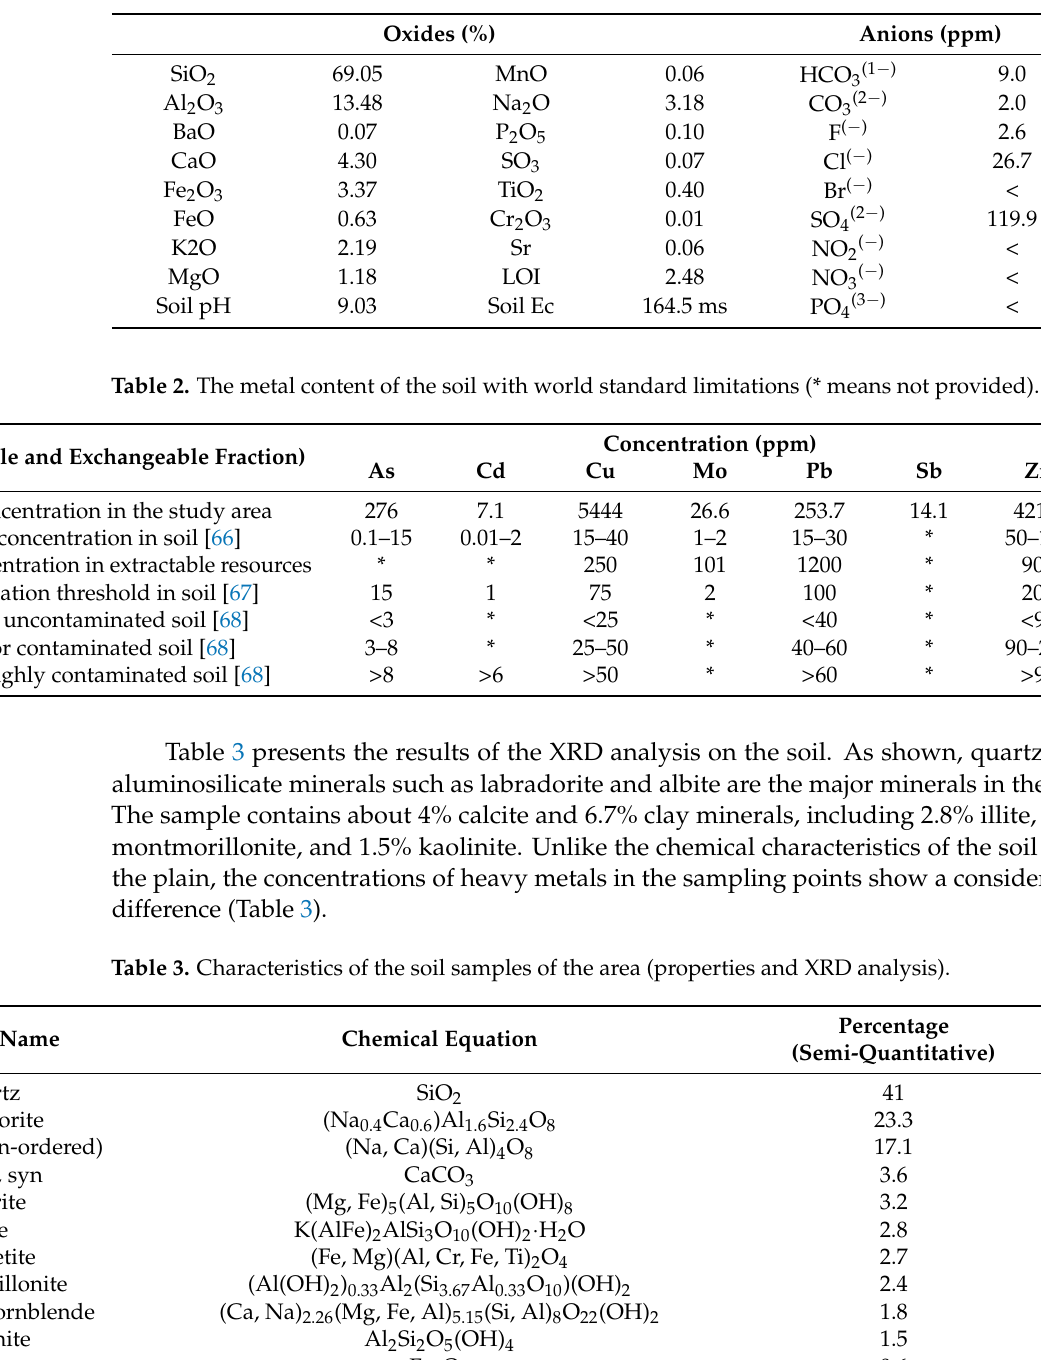
Table 1. Physical and chemical characteristics of the soil samples (anions, oxides, pH, and EC).